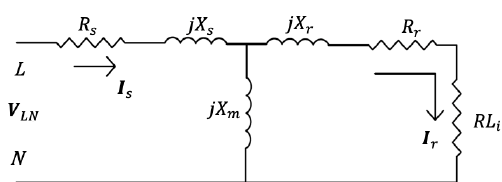
Fig. 5. Generator positive and negative sequence